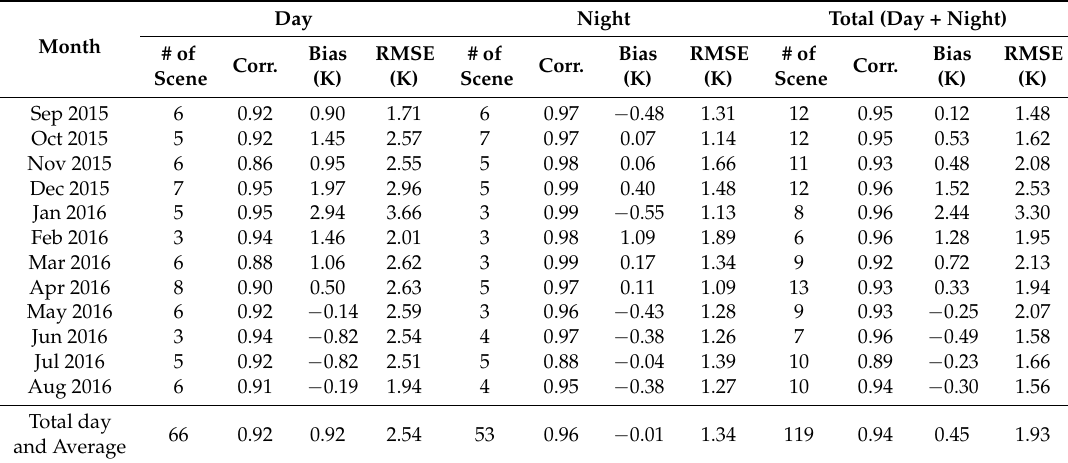
Table 3. Results of comparison between Himawari-8 LST data and MODIS LST products (collection 6)